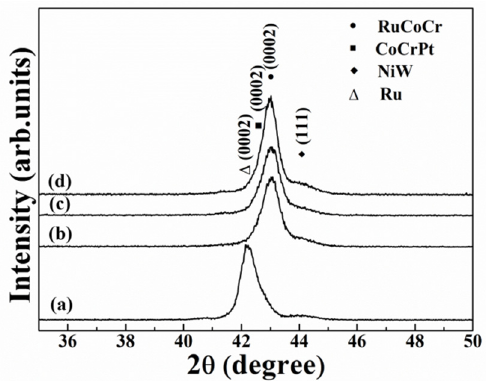
Figure 1. X-ray diffraction (XRD) patterns of CoCrPt/y/NiW/NiTa, here y is (a) Ru, (b) RuCoCr, (c) RuCoCrTi and (d) RuCoCrRe intermediate layer.